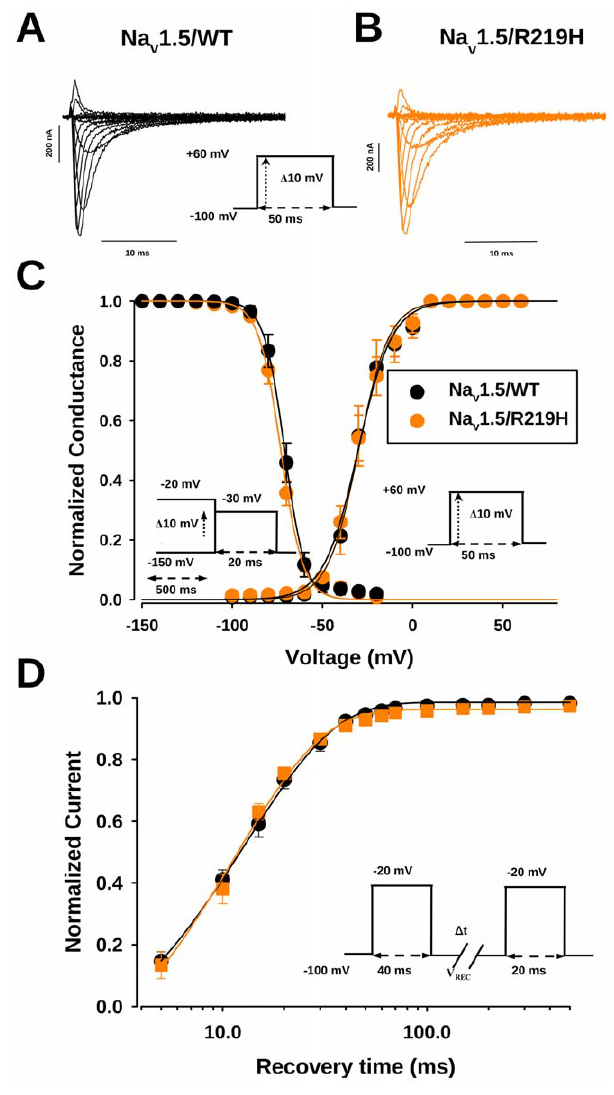
Figure 2. Biophysical characterization of the Na v 1.5/R219H DCM mutation proton current recordings. Representative current traces recorded using the cut-open oocyte technique from Na v 1.5/WT ( A ) and Na v 1.5/R219H ( B ) channels. Currents were elicited by depolarizing pulses from 2 100 mV to + 60 mV, with 10 mV increments for each step. ( C ) The voltage dependence of steady-state activation and inactivation of WT (activation, n=7; inactivation, n=8) and R219H (activation, n=8; inactivation, n=8). Activation curves were derived from I – V curves and fitted to a standard Boltzmann equation: G ( V )/ G max =1/(1 + exp (( V 2 V 1/2 )/ k v )), with midpoints (V 1/2 ) is slow factors ( k v ) listed in Table S1 . The voltage-dependence of inactivation was induced by applying conditioning pre-pulses to membrane potentials ranging from a holding potential of 2 150 to 2 20 mV for 500 ms